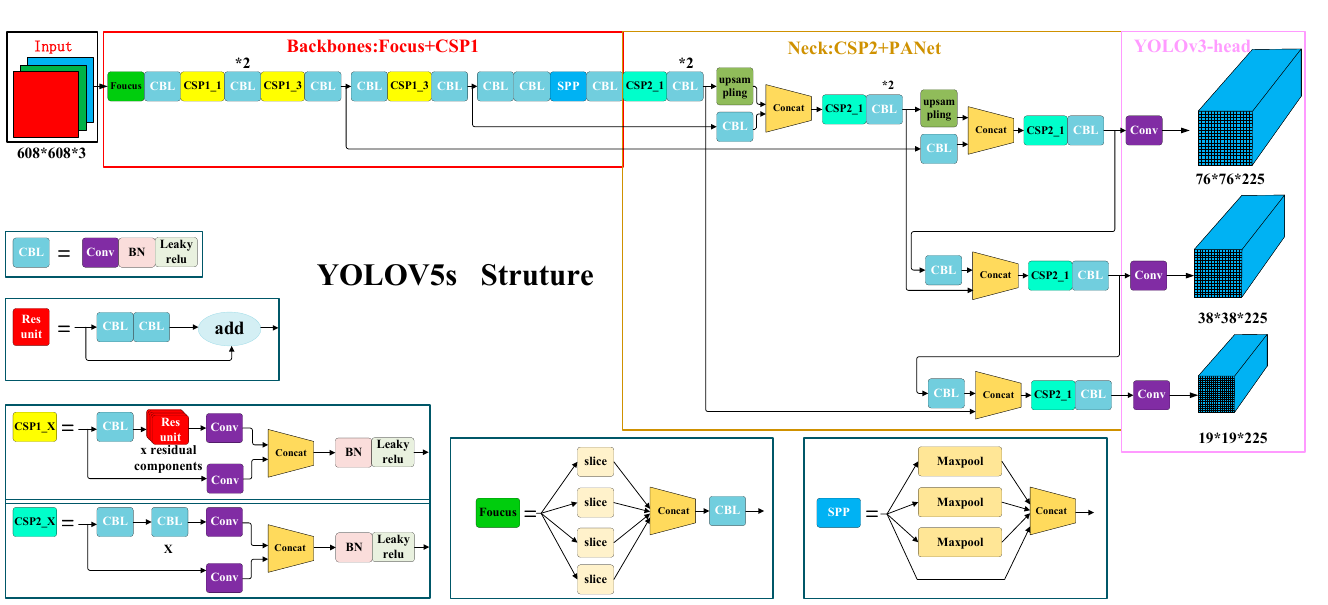
Figure 2. YOLOv5s network structure diagram. Internet source.